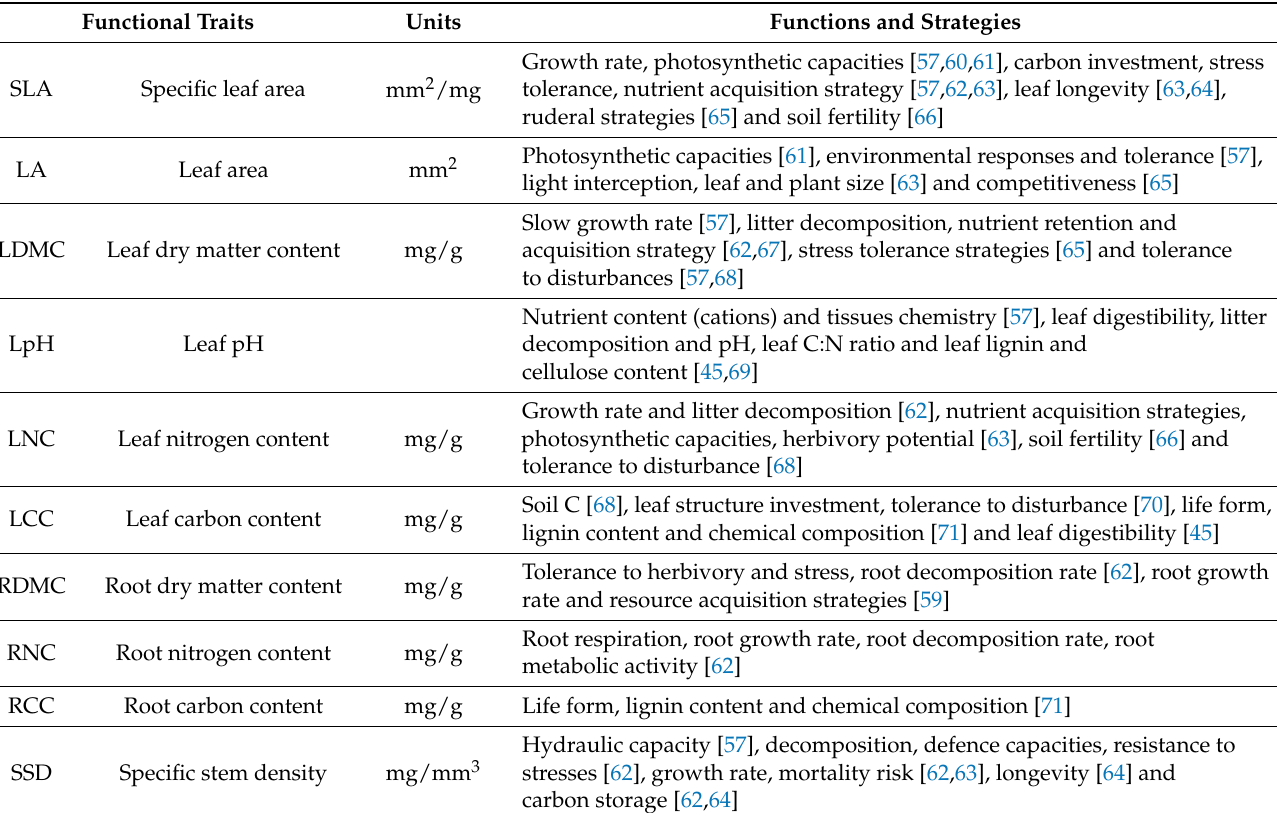
Table 2. Functional traits associated to plant strategies, ecological functions and environmental properties. Functional